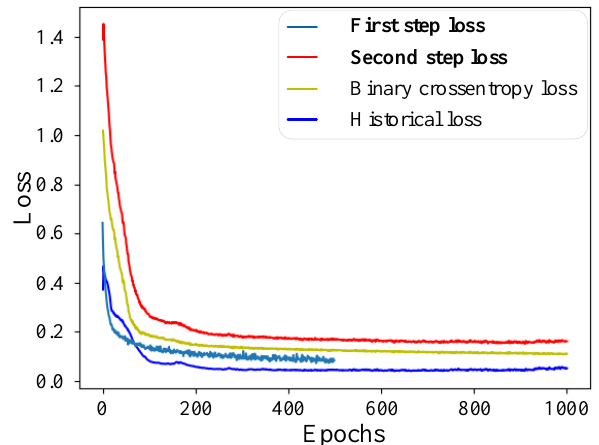
Figure 8. FLS model loss using a two-step training strategy.